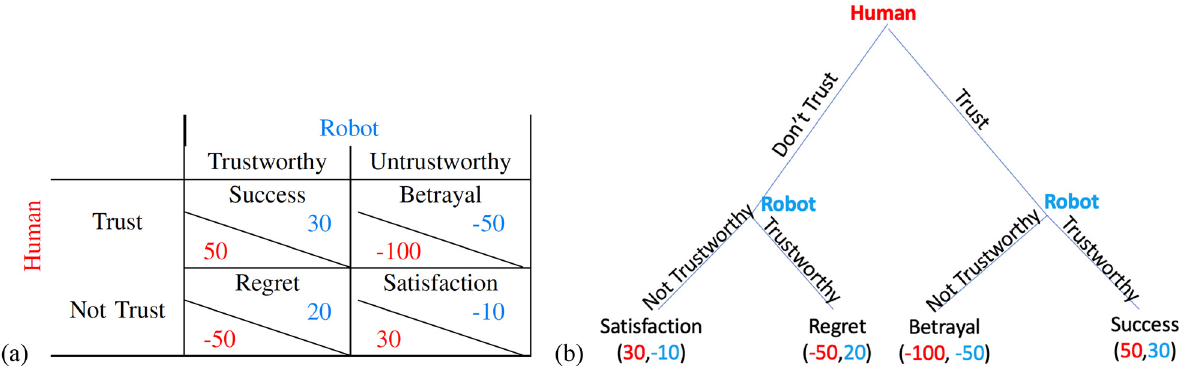
Figure 2: An illustrative example of the payo ff s in a human – robot trust interaction. The human trustor ’ s payo ff s are in red and the robot ’ s are in blue, with the game represented in two forms. ( a ) Example normal - form representation of the trust game, best suited for enabling calculations. ( b ) Extensive - form representation of the game, highlighting the sequential nature of the game, with the trustor making the fi rst “ move.